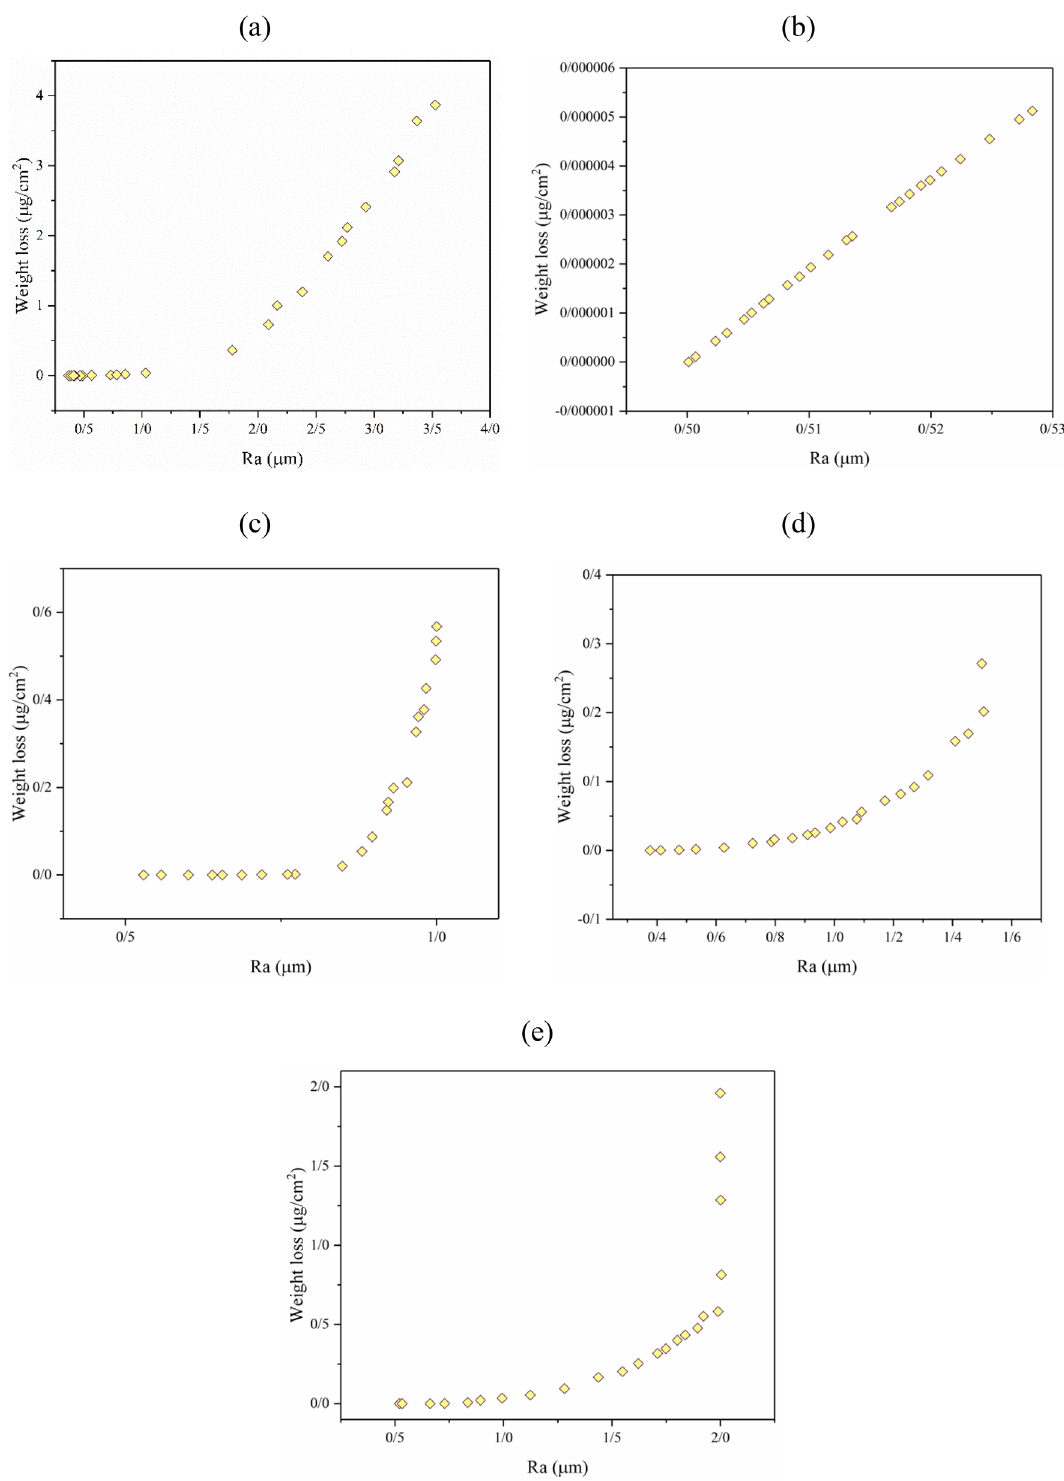
Figure 11. Multi-objective optimization of R a and WL in the etching of titanium to ( a ) maximized R a and minimized WL, ( b ) fixed R a = 0.5 and WL minimized, ( c ) fixed R a = 1 and WL minimized, ( d ) fixed R a = 1.5 and WL minimized, and ( e ) fixed R a = 2 µm and WL